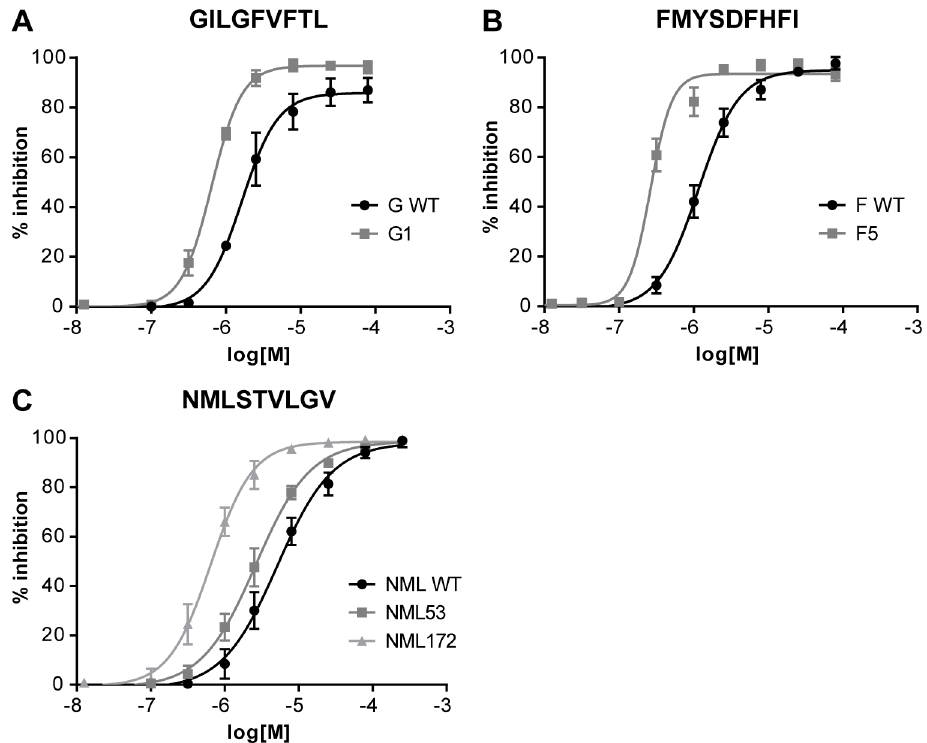
Fig 3. Binding affinity dose-response curves of CPLs and WT peptides. The IC 50 curves of the selected CPLs show increased HLA binding affinity compared to IC 50 curves of the corresponding WT-peptides. To generate IC 50 curves the FP-based competition assay was performed using threefold peptide dilutions in the presence of a standard amount of tracer peptide. Shown are averages and their standard deviation of three independent experiments. Curves of CPLs are shifted to the left compared to WT peptides, indicating that a lower dose of CPLs is needed to inhibit tracer